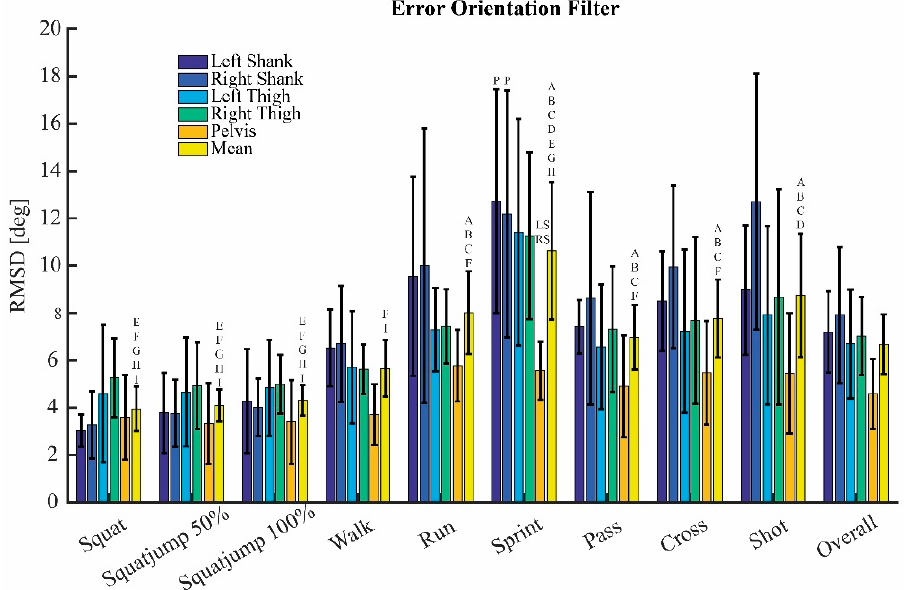
Figure A2. Error of the orientation filter. Mean root-mean-square differences (RMSD) and standard deviations for all body segments and all trials. Significant differences within each trial between body segments are displayed by letters above the bar, LS, RS, LT, RT, and P mean a significant difference with the left shank, right shank, left thigh, right thigh, and pelvis, respectively. Significant differences between trails are displayed with a letter above the mean bar. A = squat, B = squat jump 50%, C = squat jump 100%, D = walk, E = run, F = sprint, G = pass, H = cross and I = shot.